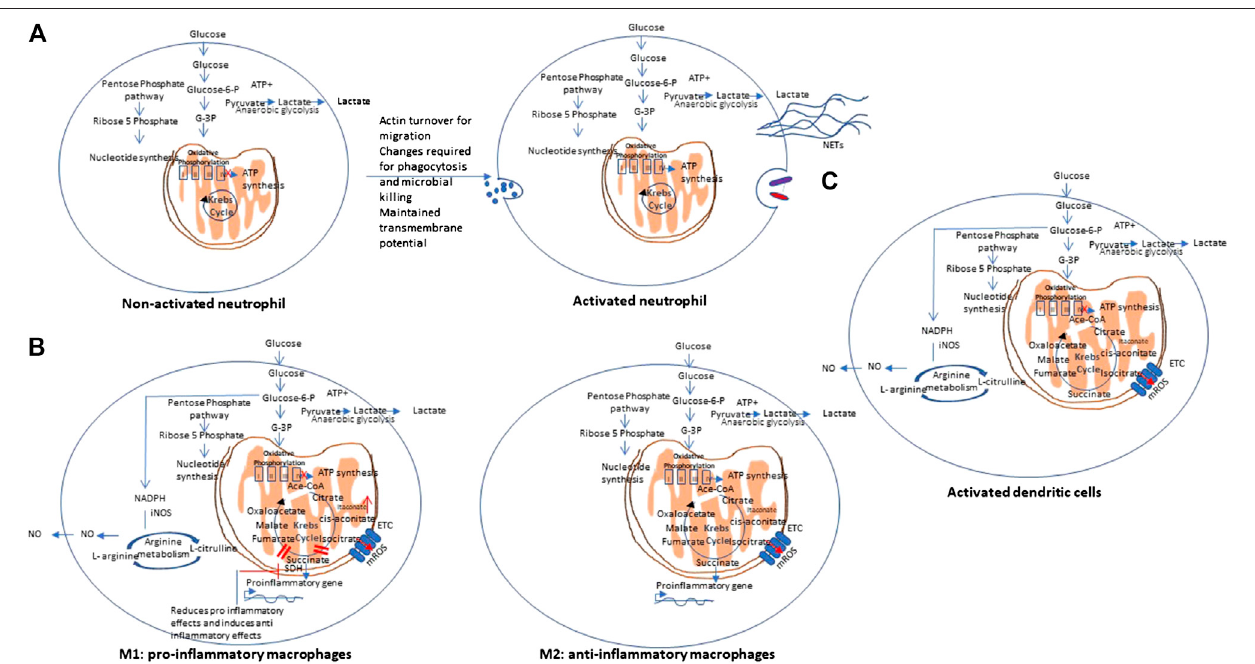
FIGURE 4 | Metabolic pathways of other immune cells. (A) Non-activated vs. activated neutrophils: Polymorphonuclear cells are mainly glycolytic in nature, and have few mitochondria, and produce low energy from respiration to ensures their function at low oxygen concentrations (even anoxia) and maintain a transmembrane potential via the glycerol-3-phosphate shuttle. NETs: Neutrophil extracellular traps. (B) Metabolic pathways of Macrophages: Macrophages may show differential metabolism depending on their extreme: a pro-in fl ammatory (M1) and an anti-in fl ammatory/pro-resolving (M2). M1 macrophages are dependent solely on glycolysisandpresenttwobreaksontheTCAcycle,causingcollectionofitaconateandsuccinate.Incontrast,M2cellsaremainlydependonOXPHOS,anddonotshow anybreakinTCAcycleandprovidesthesubstratesfortheelectron transportchain(ETC).Onstimulationwithlipopolysaccharides(LPS)andotherpathogen-associated molecularpatterns,macrophagesshowmitochondrialcollapse(meaningadecreaseinATPproduction)thatresultedfromnitricoxide(NO)productionfromarginine. (C) Metabolic pathway of dendritic cells. Dendritic cells (DCs), on stimulation, show decreased OXPHOS, with simultaneous increase in glycolysis and pentose phosphate pathway activity, similar to M1 macrophages. On activation with lipopolysaccharides (LPS) and other pathogen-associated molecular patterns, both DCs also show mitochondrial collapse (meaning a decrease in ATP production) that resulted from nitric oxide (NO) production from arginine.